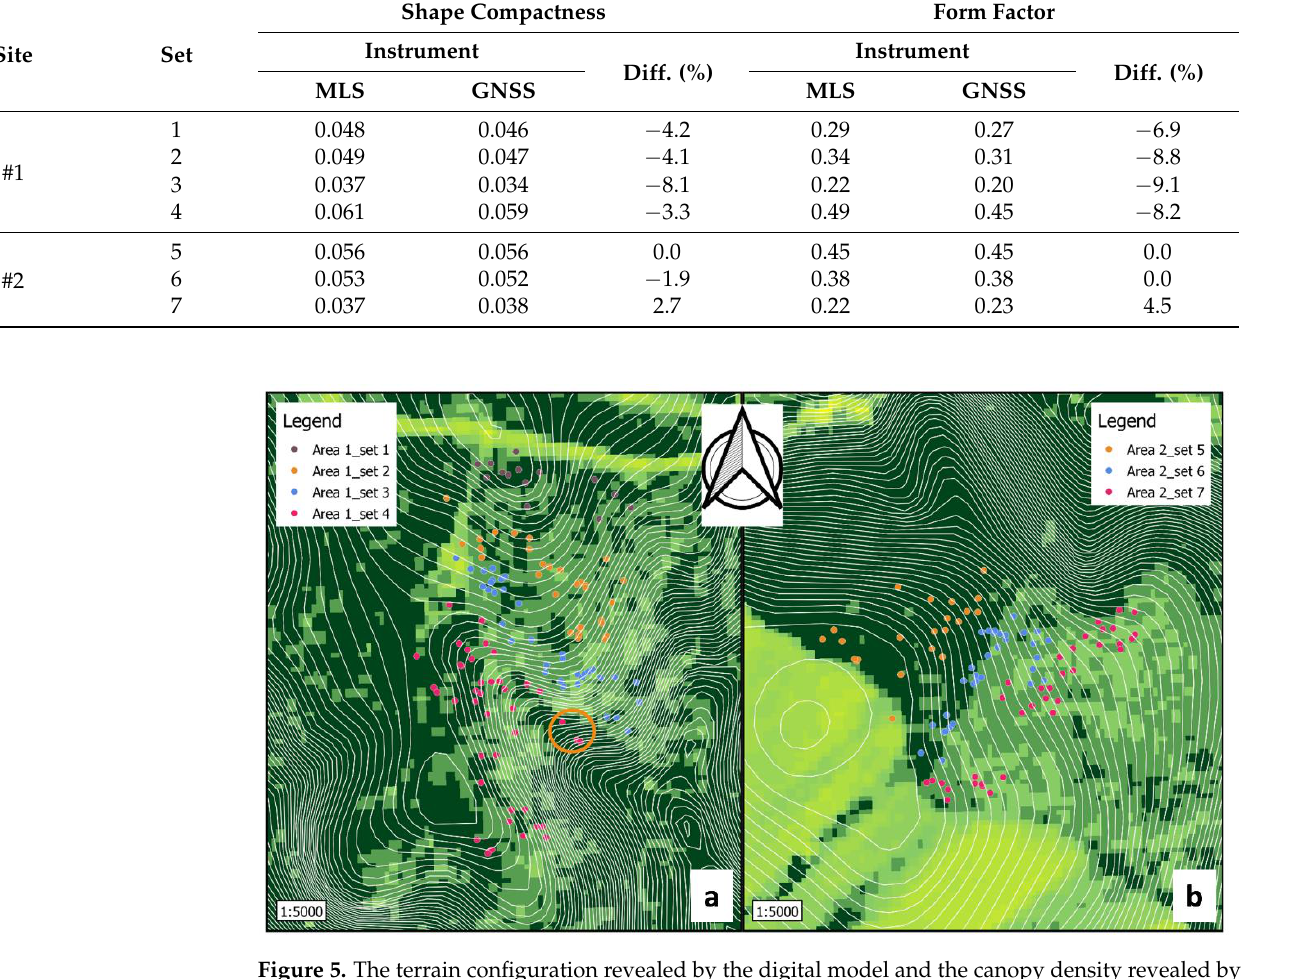
Figure 5. The terrain configuration revealed by the digital model and the canopy density revealed by the EVI classified image for the two analyzed areas ( a —datasets 1 to 4; b —datasets 5 to 7). Nuances of green represent different canopy densities (with light green for open space and darkest green for fully closed dense canopy). The orange circle on the left image shows examples of nests located both under dense canopies and under steep terrain conditions.